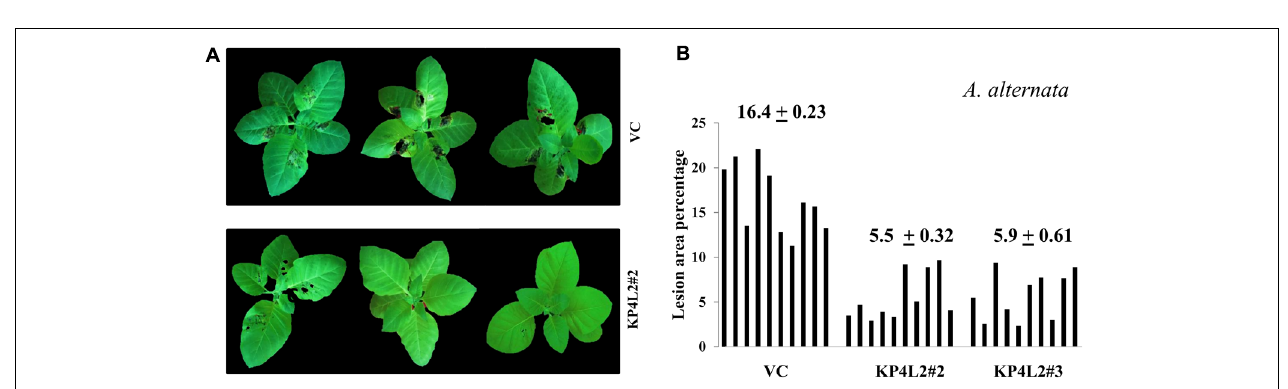
FIGURE 9 | (A,B) P. exigua var. exigua disease resistance assays on detached leaves of VC, KP4L2#2, and KP4L2#3 indicating lesion development two and half weeks post-infection. (C) Graph showing lesion area percentage along with respective means and SE.